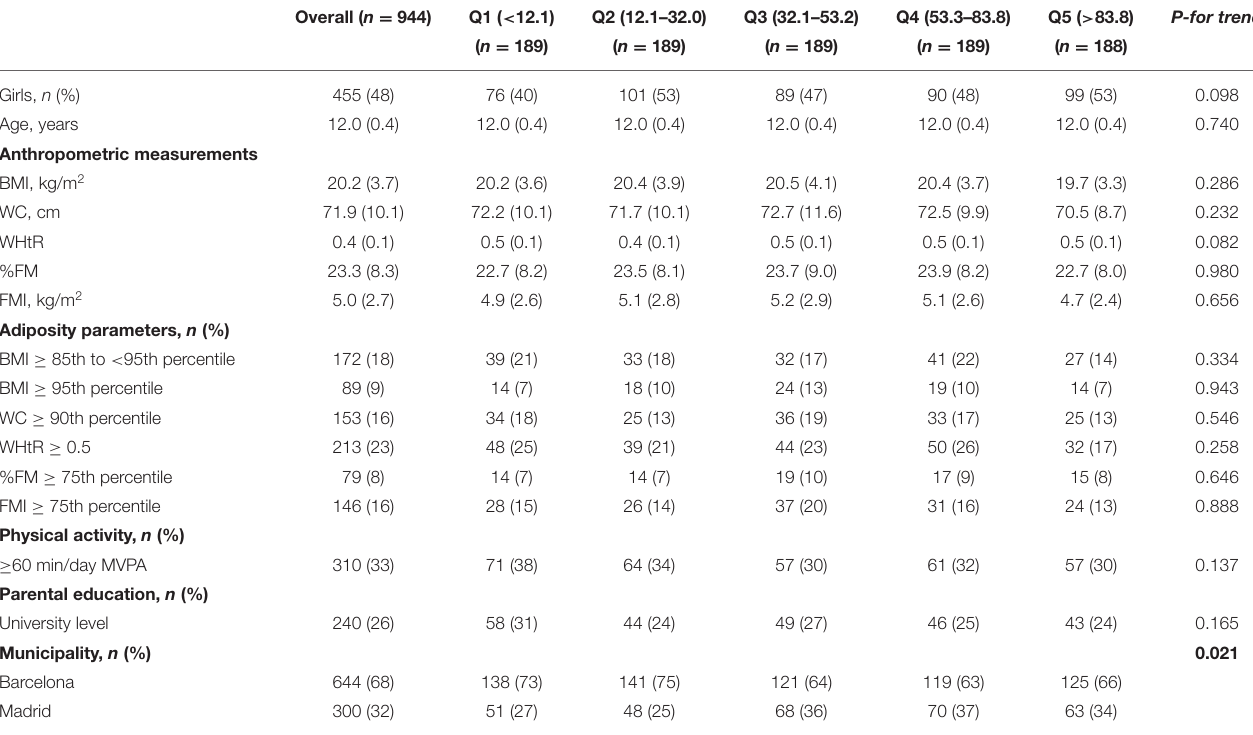
TABLE 1 | Characteristics of participants according to quintiles of flavonoid intake from cocoa-based products